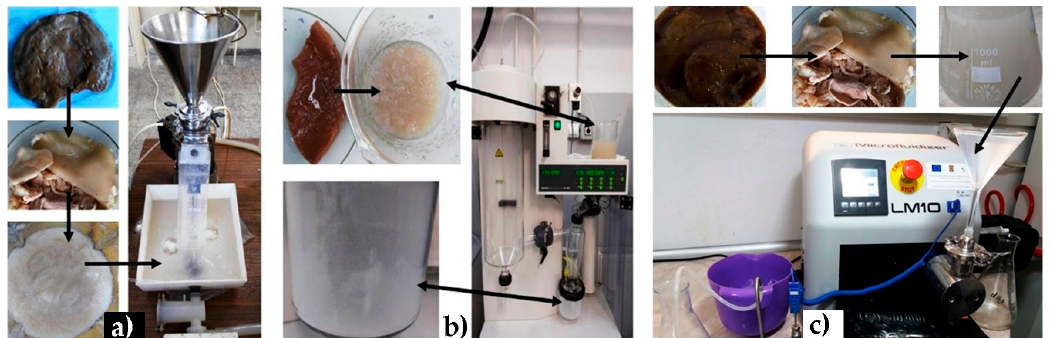
Figure 1. Main steps in purification and nanocellulose (NC): ( a ) purification, grinding with a blender, and deep grinding with a colloidal mill; ( b ) purification and atomization using a spray-dryer; ( c ) purification and microfluidization at pressures over 1300 bar.